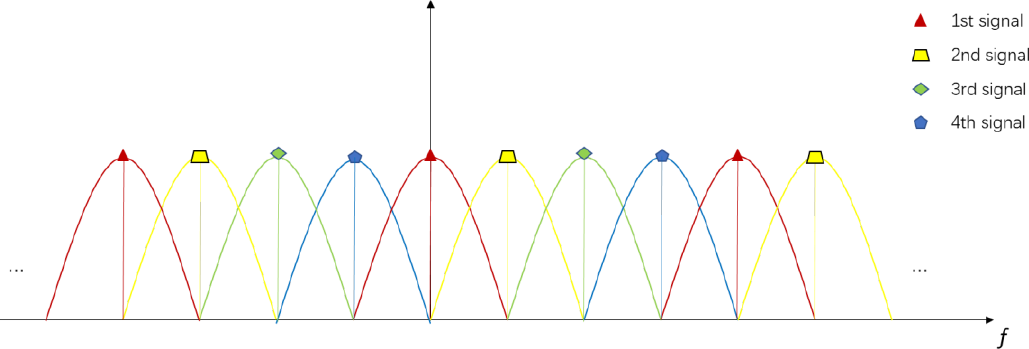
Figure 2. Orthogonal frequency division multiplexing (OFDM) chirp signal in frequency domain.